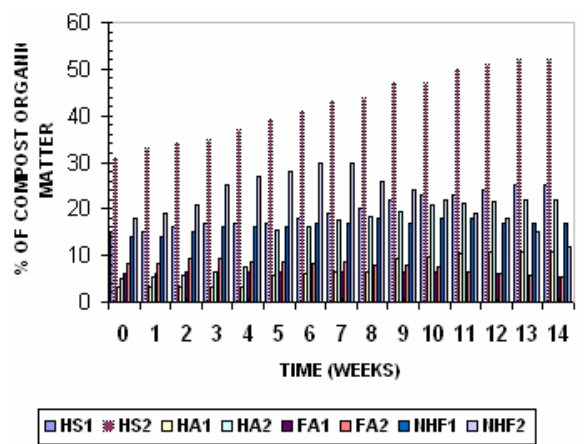
Fig 4: Variation of humic and non humic substances during